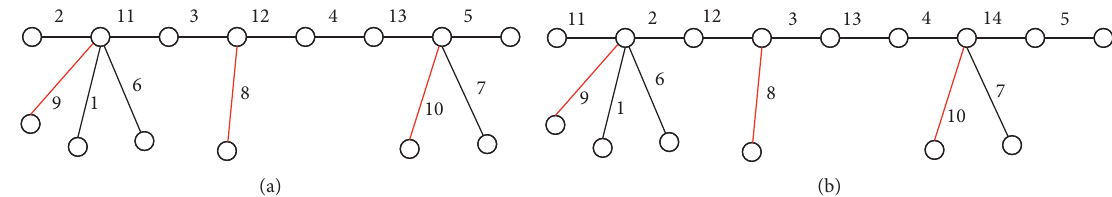
Figure 1: Examples of product antimagic labelings of caterpillars: (a) a caterpillar with the spine containing odd number of edges; (b) a caterpillar with the spine containing even number of